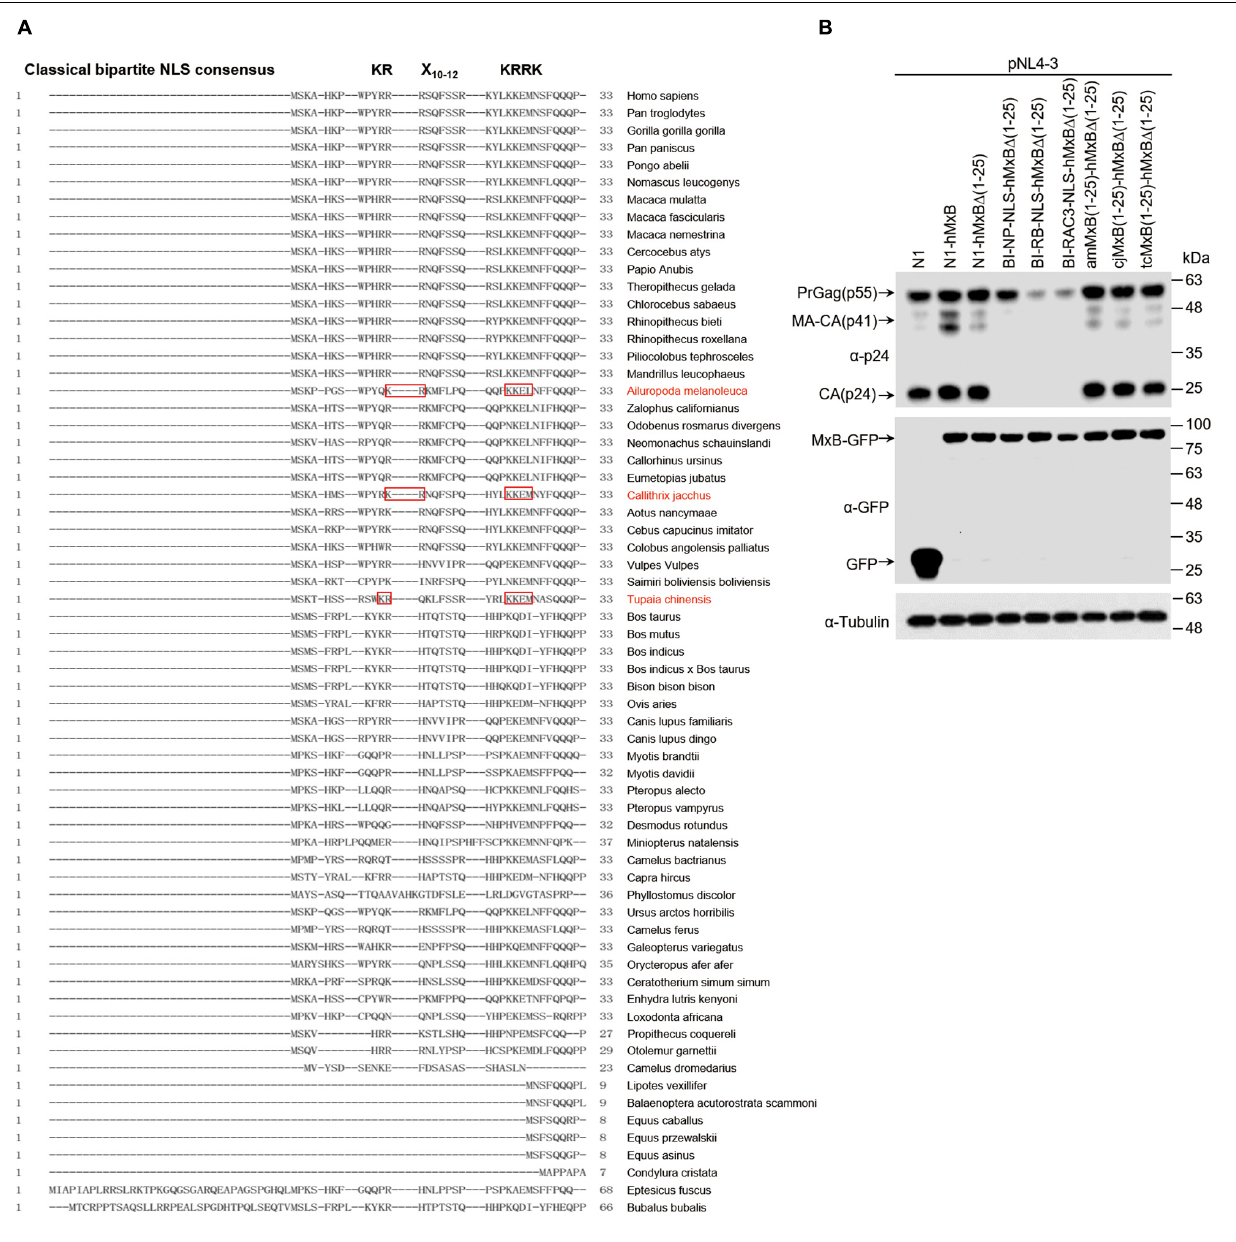
FIGURE 5 | The search for MxB orthologs carrying bipartite NLS. (A) Alignment of N-terminal sequences of MxB proteins from 65 species. The bipartite NLS consensus sequence is depicted in bold at the top of the aligned sequences. Highlighted in red boxes are the N-terminal sequences of MxB proteins from three species that contains bipartite-like NLS. (B) HEK293T cells were transfected with wild type or mutant MxB DNA together with HIV-1 NL4-3 proviral DNA. At 48 h post-transfection, the transfected cells were subjected to Western blotting to examine the levels of Gag/p24 and MxB. Tubulin was detected as the internal